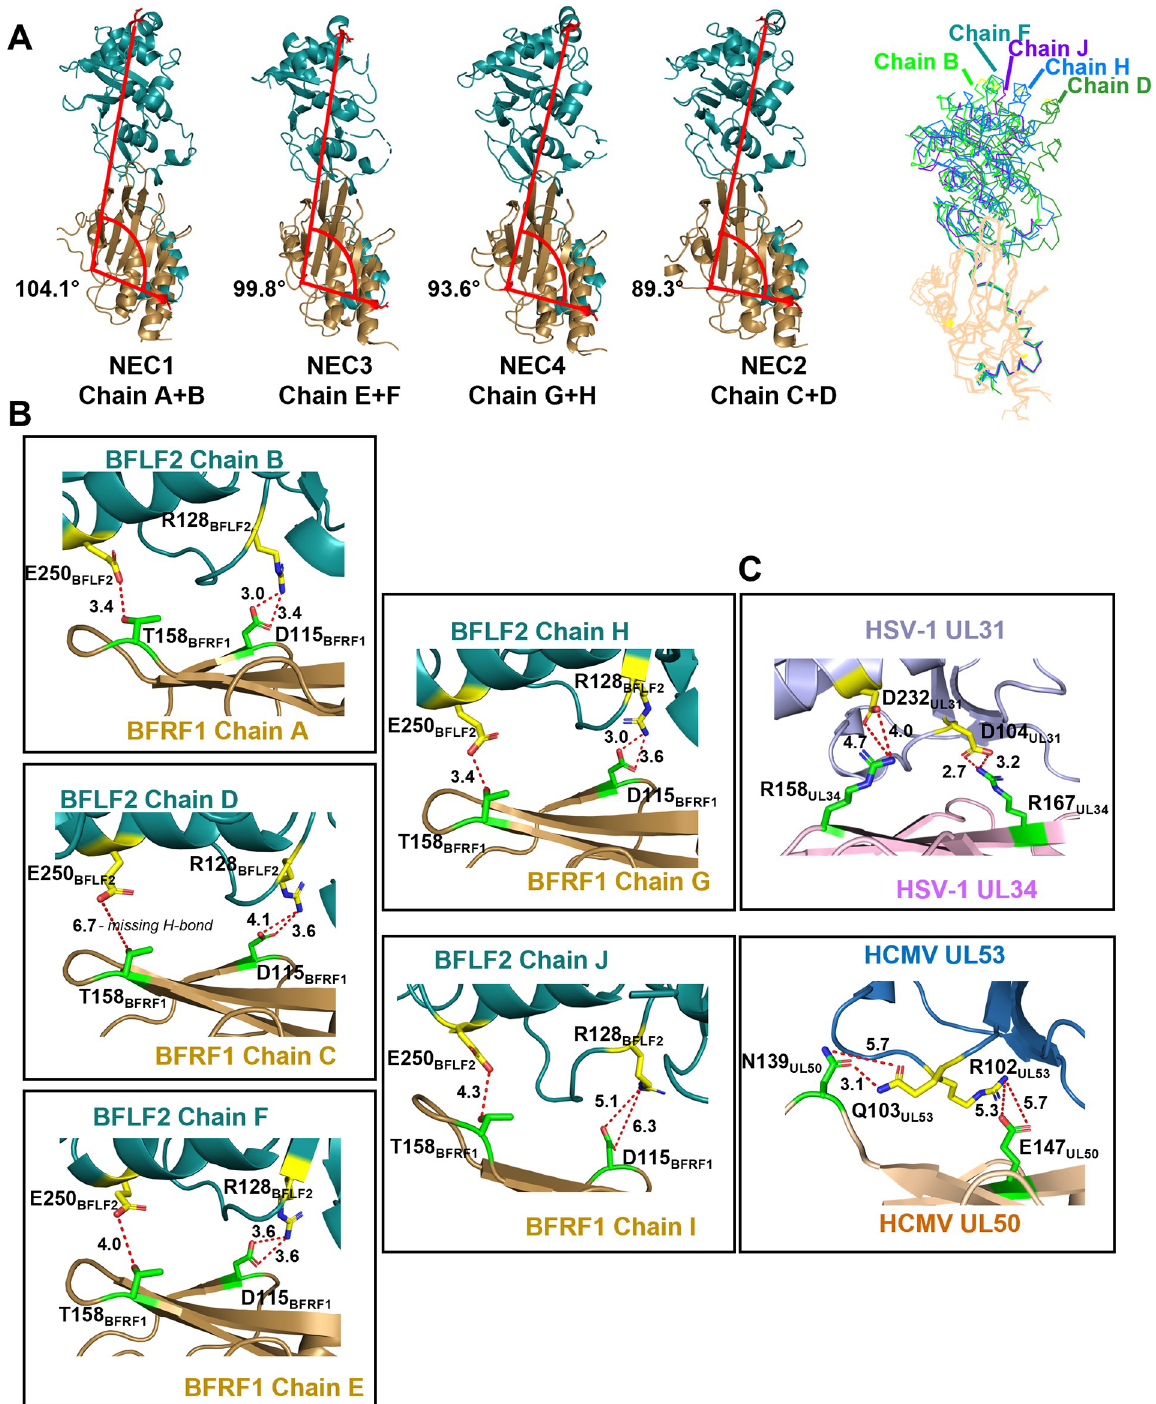
Fig 3. BFLF2 adopts different tilt angles relative to BFRF1. (A) Crystal structures of EBV NEC heterodimers, arranged in the order from those with the largest tilt angle to those with the smallest tilt angle. Tilt angle (red line) was measured from the C α atoms of D10 BFRF1 /P98 BFRF1 / D287 BFLF2 . D287 BFFL2 was unresolved in chain J, and thus the tilt angle could not be determined for NEC5 (chains I/J). BFLF2 (teal) and BFRF1 (tan). The last image shows an overlay of all 5 NECs with BFLF2 chain B (neon green), chain D (green), chain F (teal), chain H (blue), chain J (purple) and BFRF1 (tan). (B) Close-up view of the globular domain interactions between BFLF2 (teal) and BFRF1 (tan). Polar contact residues for BFLF2 (yellow) and BFRF1 (green) are shown with measurements ( Å ). (C) Close-up view of the globular domain interactions between HSV- 1 UL31 (light purple) and UL34 (light pink) vs. HCMV UL53 (blue) and UL50 (tan). Polar contact residues for UL31/UL53 (yellow) and UL34/